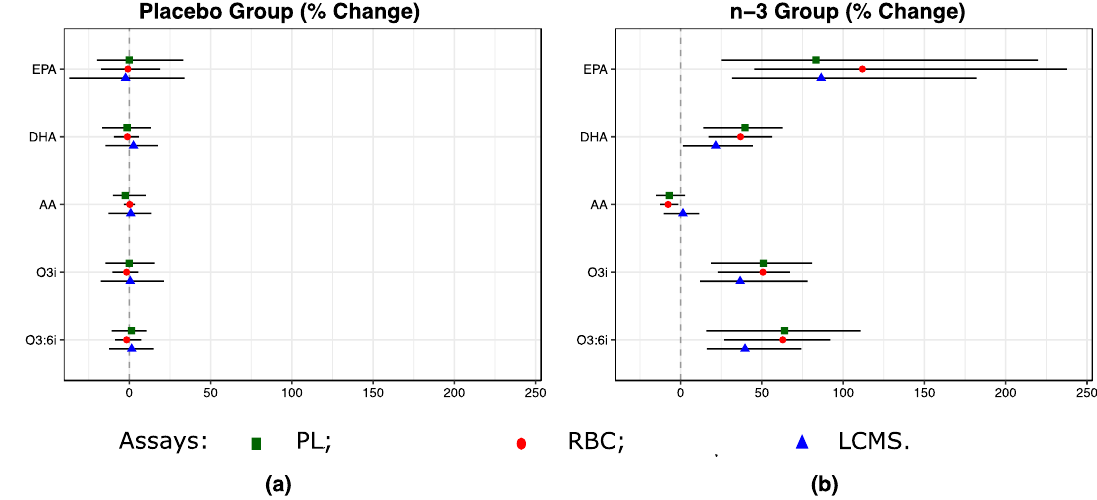
Figure 3. One-year % changes in EPA, DHA, AA, and combined levels according to the randomized treatment assignment ( a ) n-3 vs. ( b ) placebo in VITAL200. Shapes and error bars denote medians and IQRs. See footnote in Figure 2 and Abbreviations.